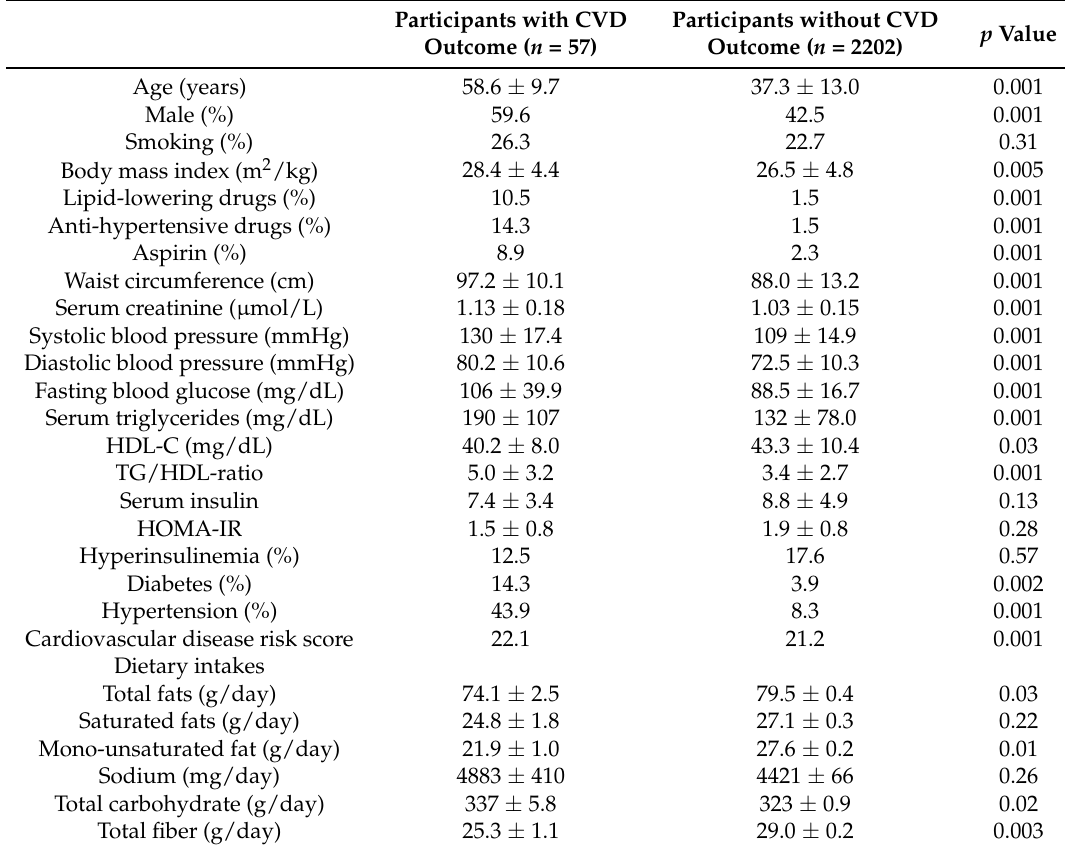
Table 1. Baseline characteristics of the